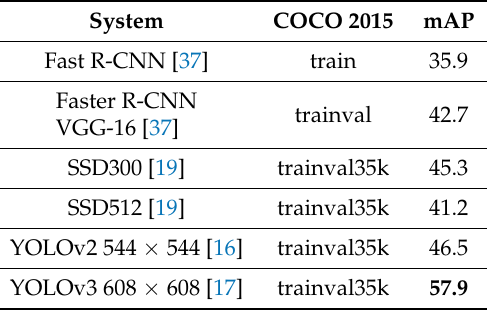
Table 7. Comparison of accuracy between detectors on the COCO